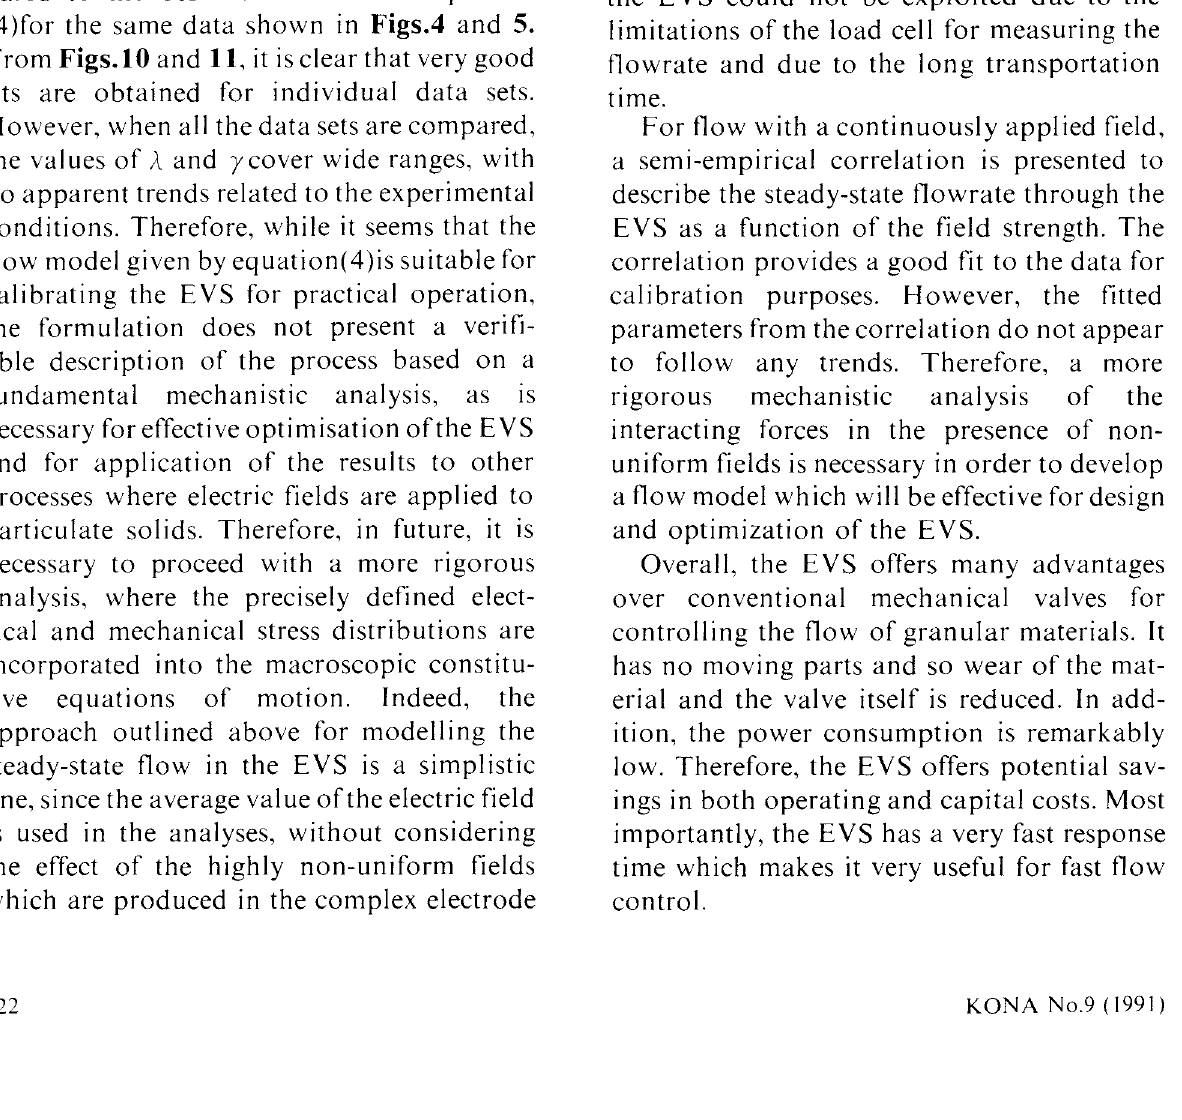
Fig.ll Fit of flow modeL equation(4), to experi mental date from Fig.S for rectangular column. Experimental:O, sand; o, grass ballotini. Best fit from